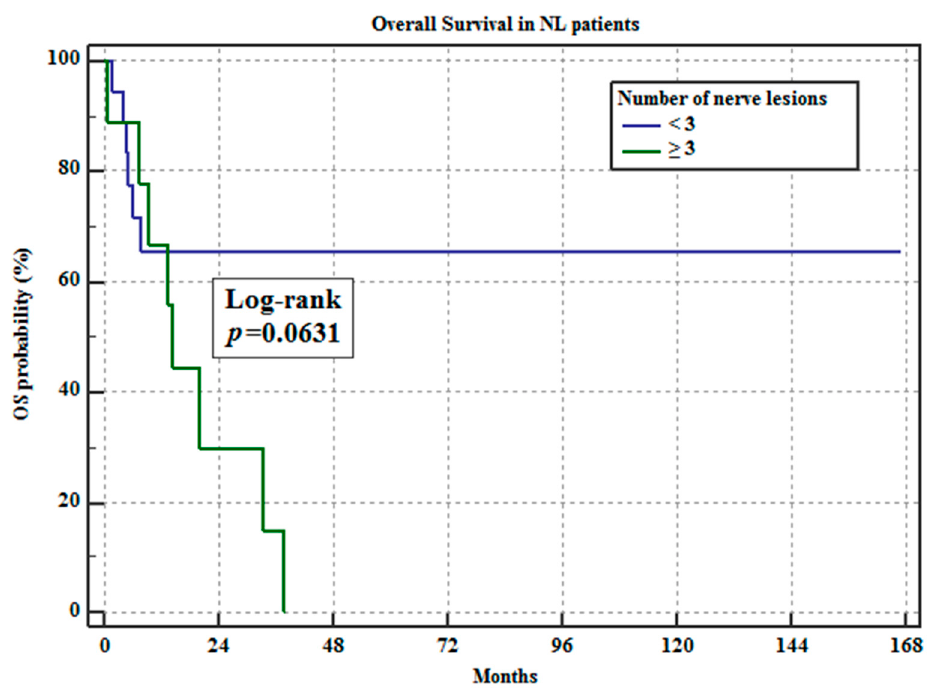
Figure 6. Kaplan–Meier analysis for OS.